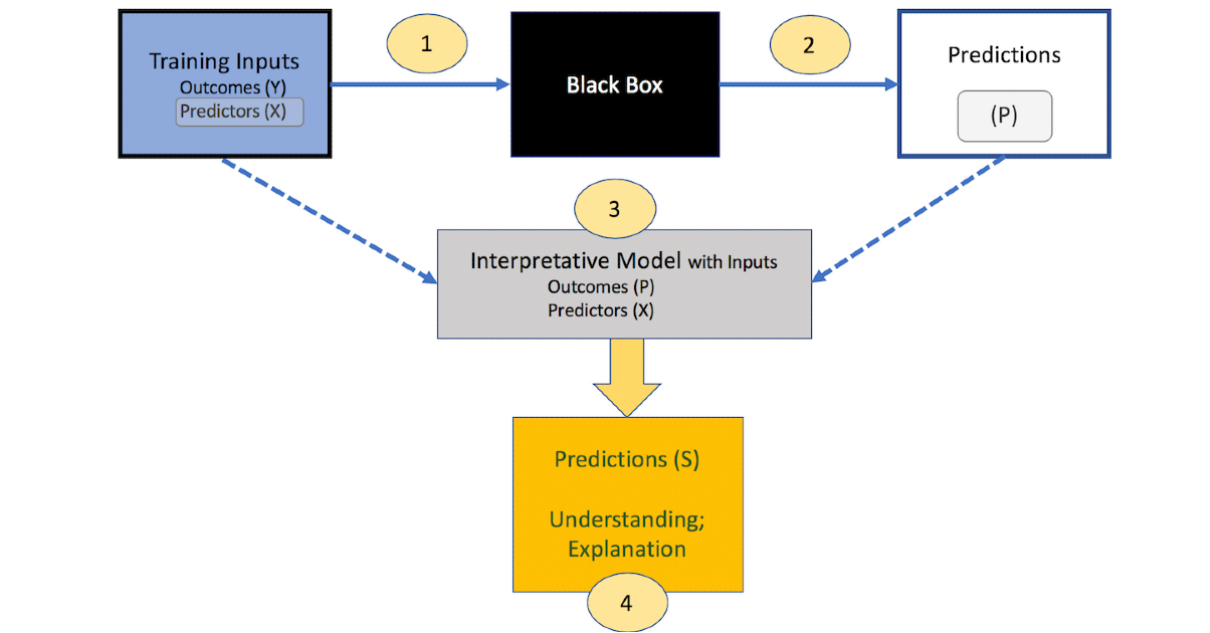
Figure 1. Steps to present machine learning (ML) predictions in an interpretable manner: The black box algorithm is applied to input data comprising outcomes (Y) and predictors (X) to obtain black-box predictions (P) of the input outcomes. The original X variables and the black-box predictions (P) are inputs to a simple model or algorithm, for example a single tree, whose predictions (S) are sufficiently close to (P) but more easily understood and explained.